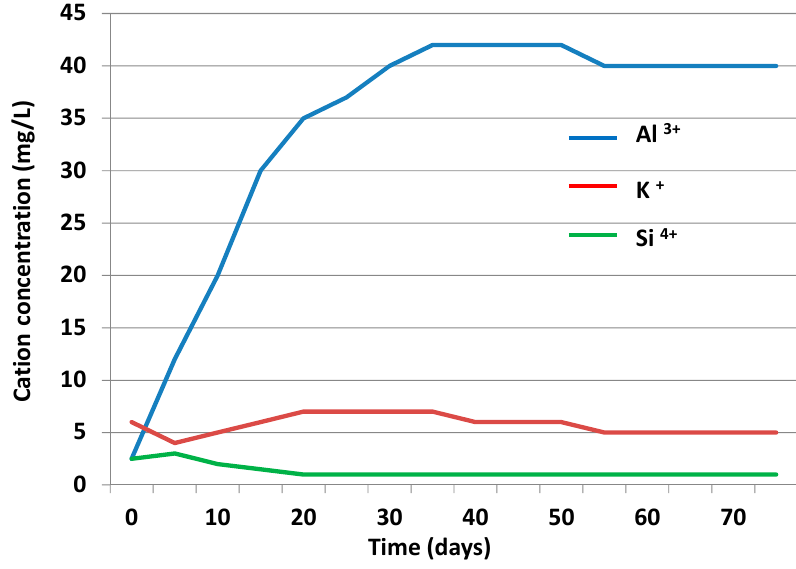
Figure 9. Behavior of ions during reaction in the kaolin activated at 600 ◦ C / 2 h.